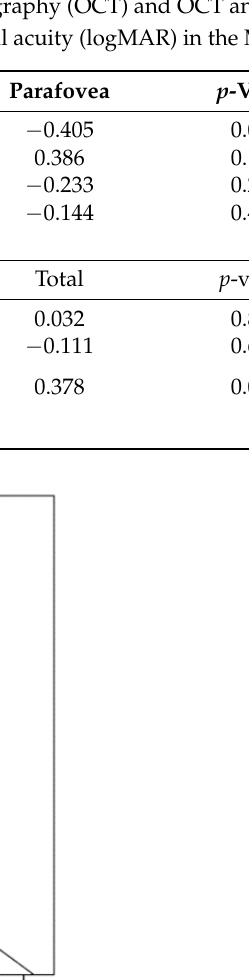
Table 6. Spearman’s rank correlation of optical coherence tomography (OCT) and OCT angiography